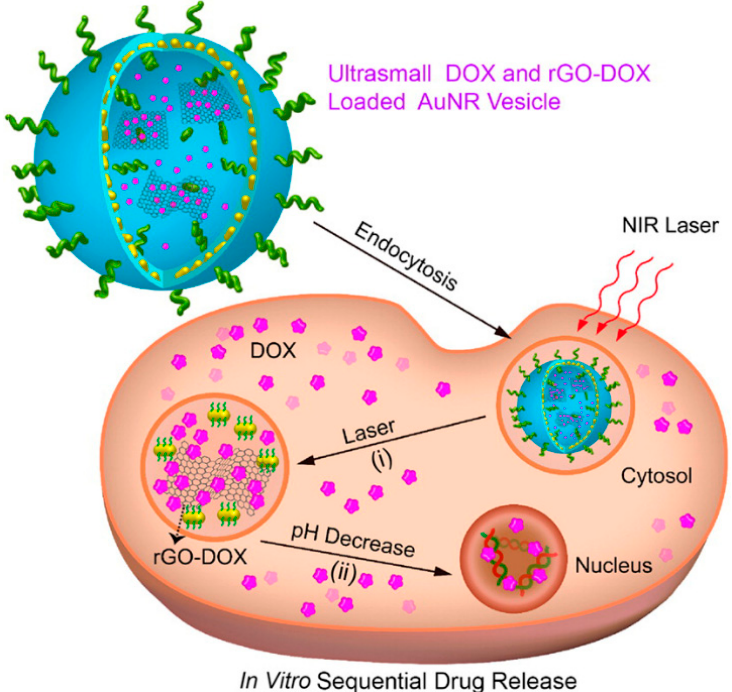
Figure 13. Schematic illustration of sequential DOX release triggered by ( i ) remote NIR laser irradiated photothermal effect and ( ii ) acidic environment of the cancer cell [102].